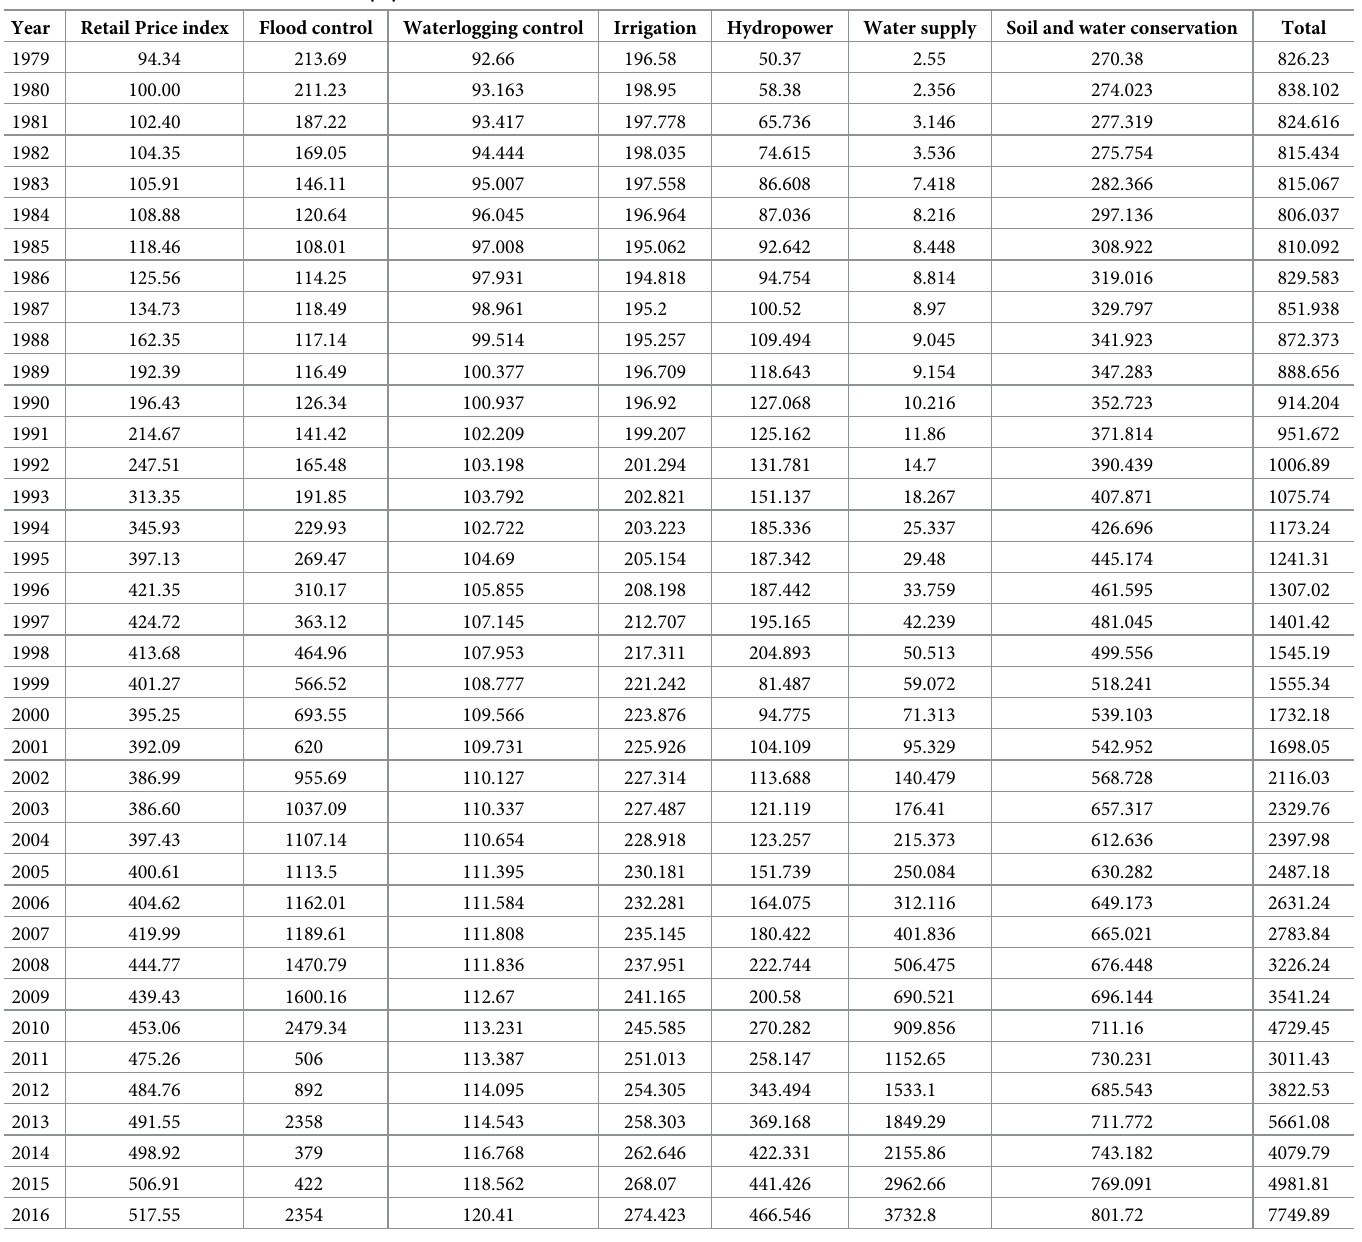
Table 1. Benefits from the water conservancy system from 1979 to